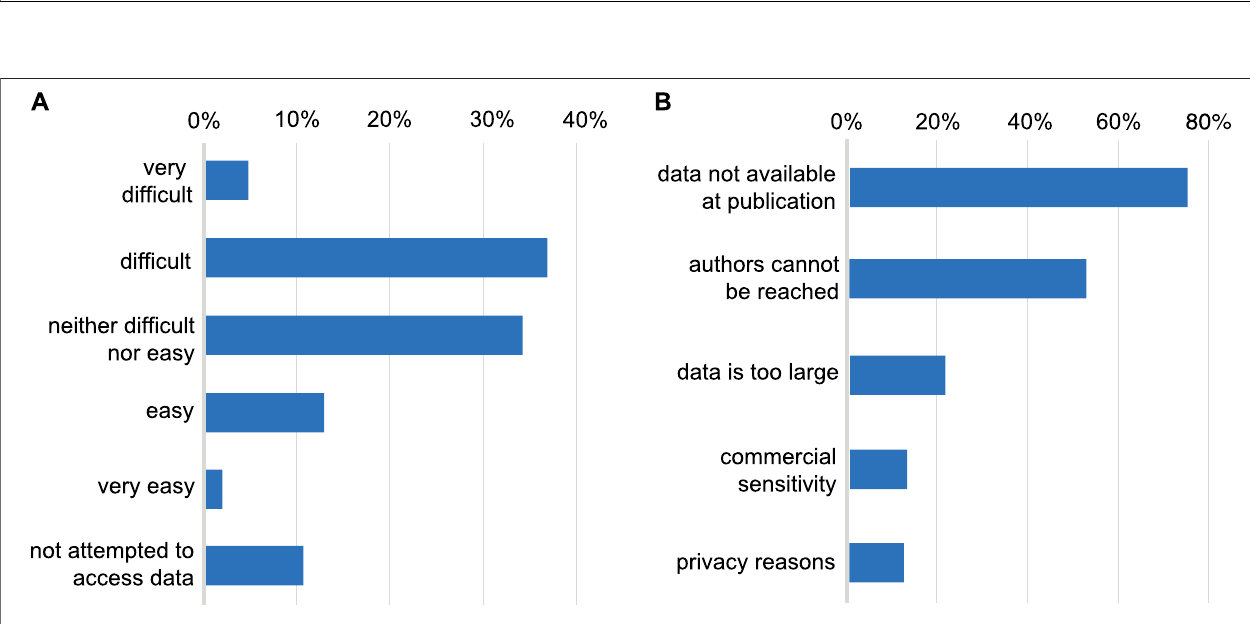
FIGURE 2 | (A) : Dif fi culty encountered accessing data underlying published research. Whether respondents have attempted to access data underlying previous publications and the level of dif fi culty typically encountered in doing so. (B) : Reasons given for dif fi culty accessing data. The reasons given by respondents for being unable to access data (restricted to those who have attempted to access